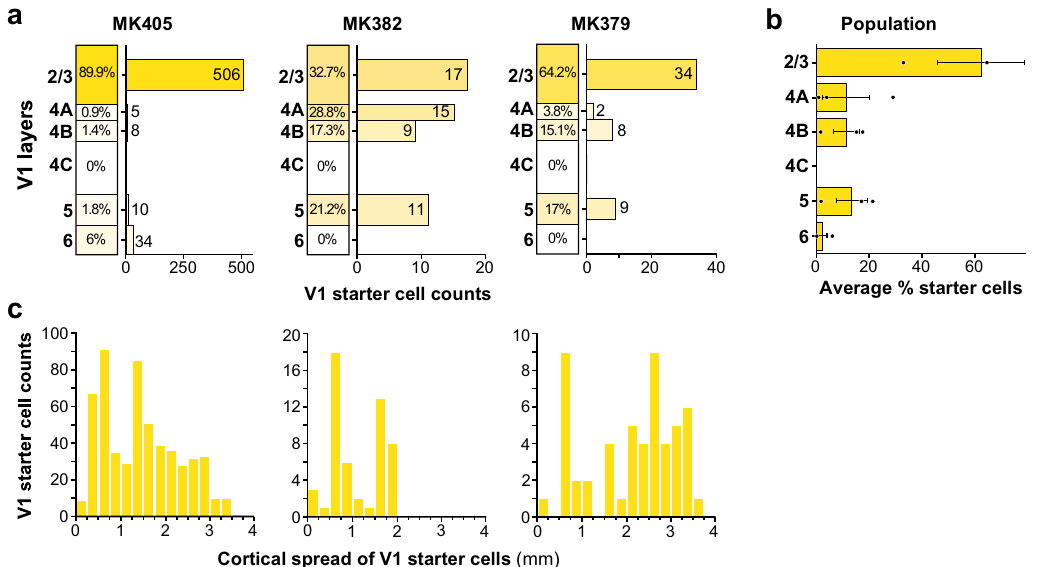
Fig. 4 Laminar and tangential distribution of double-labeled “ starter ” cells in V1. a For each of the three cases, we show the percentage (left column) and the number (right bar graph) of V1 → V2 double-labeled cells across V1 layers. b Average percent of double-labeled cells across V1 layers for the population ( n = 668 cells in 3 independent animals). Error bars: s.e.m. c Distribution of double-labeled V1 cells across the tangential domain of V1, collapsed across layers, for each case. Zero represents the location of the most medial double-labeled cell and the bin with the largest number represents the most lateral location of double-labeled The population average ratio of a total number of V2 GFP- V1 → V2 starter cells pooled across V1 layers was 2.1 ± 1.2 for L2/ labeled input neurons to a total number of V1 → V2 starter cells 3, 6.1 ± 5.4 for L5, and 0.3 ± 0.3 for L6 (Fig. 5d). The variability in (pooled across layers) was 8.7 ± 6.98; the average ratio of GFP- this ratio across cases was due to case MK379, for which there labeled V2 FB cells in each layer to the total number of were about 23 total V2 FB input cells per V1 starter cell, while this